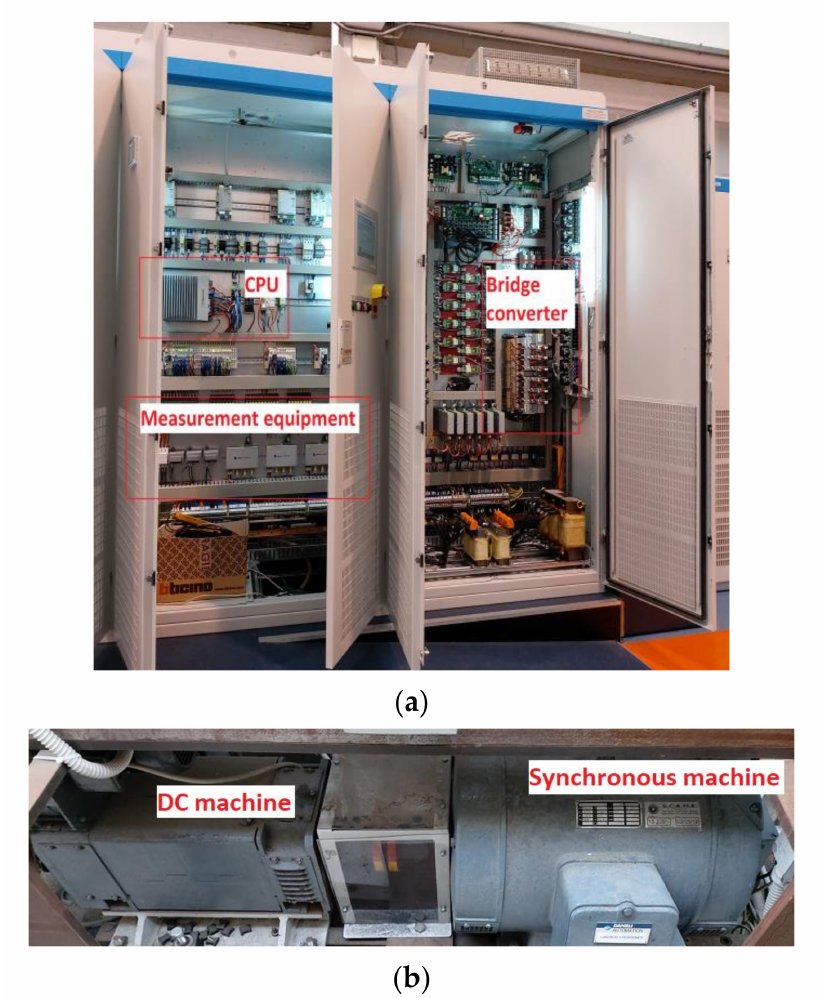
Figure 9. ( a ) Control and the power part (one phase) of the cycloconverter; ( b ) Salient pole EESM and DC machine